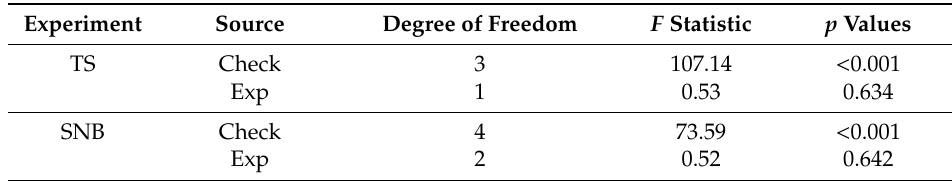
Table 1. Analysis of variation for fixed e ff ects in TS and SNB experiments of the PBW343 / Kenya Nyangumi population.